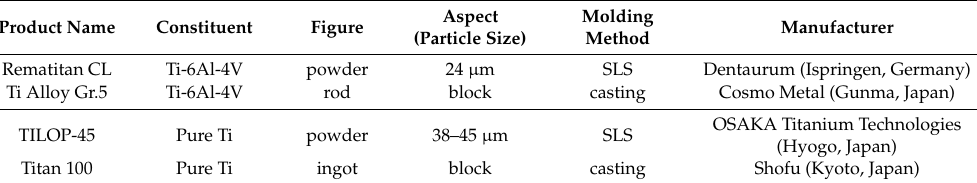
Table 1. Metals used in this